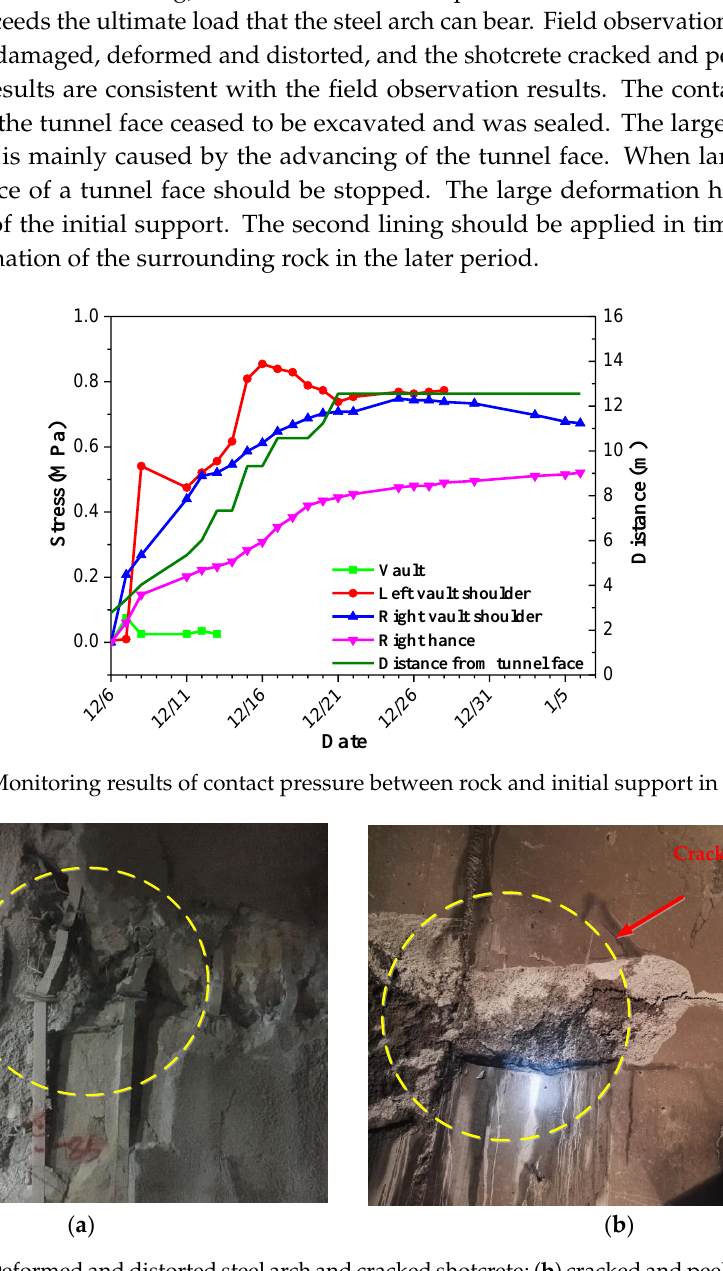
Figure 12. ( a ) Deformed and distorted steel arch and cracked shotcrete; ( b ) cracked and peeled shotcrete.